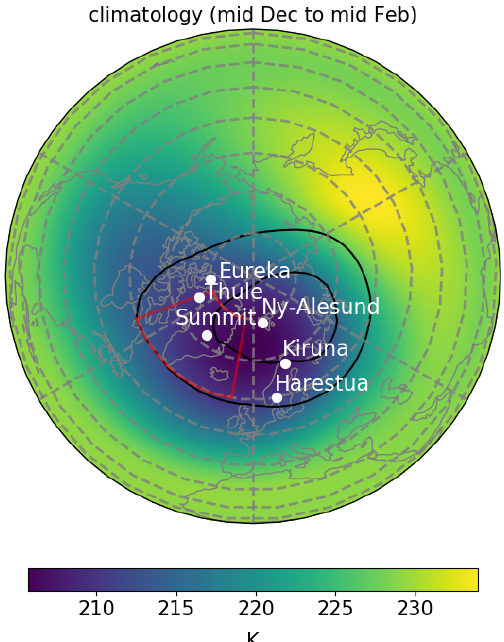
Figure 1. The climatology of temperature at 10hPa and EPV at the potential temperature of 850K during wintertime (DJF) over the Northern Hemisphere. The climatology is based on non-SSW years from 2004 to 2019. The map coloring shows the average winter temperature. The black contour lines are 600 and 800 EPV units (10 − 6 Km 2 kg − 1 s − 1 ). The locations of the observational sites are shown by white dots. Greenland sector is shown by the red